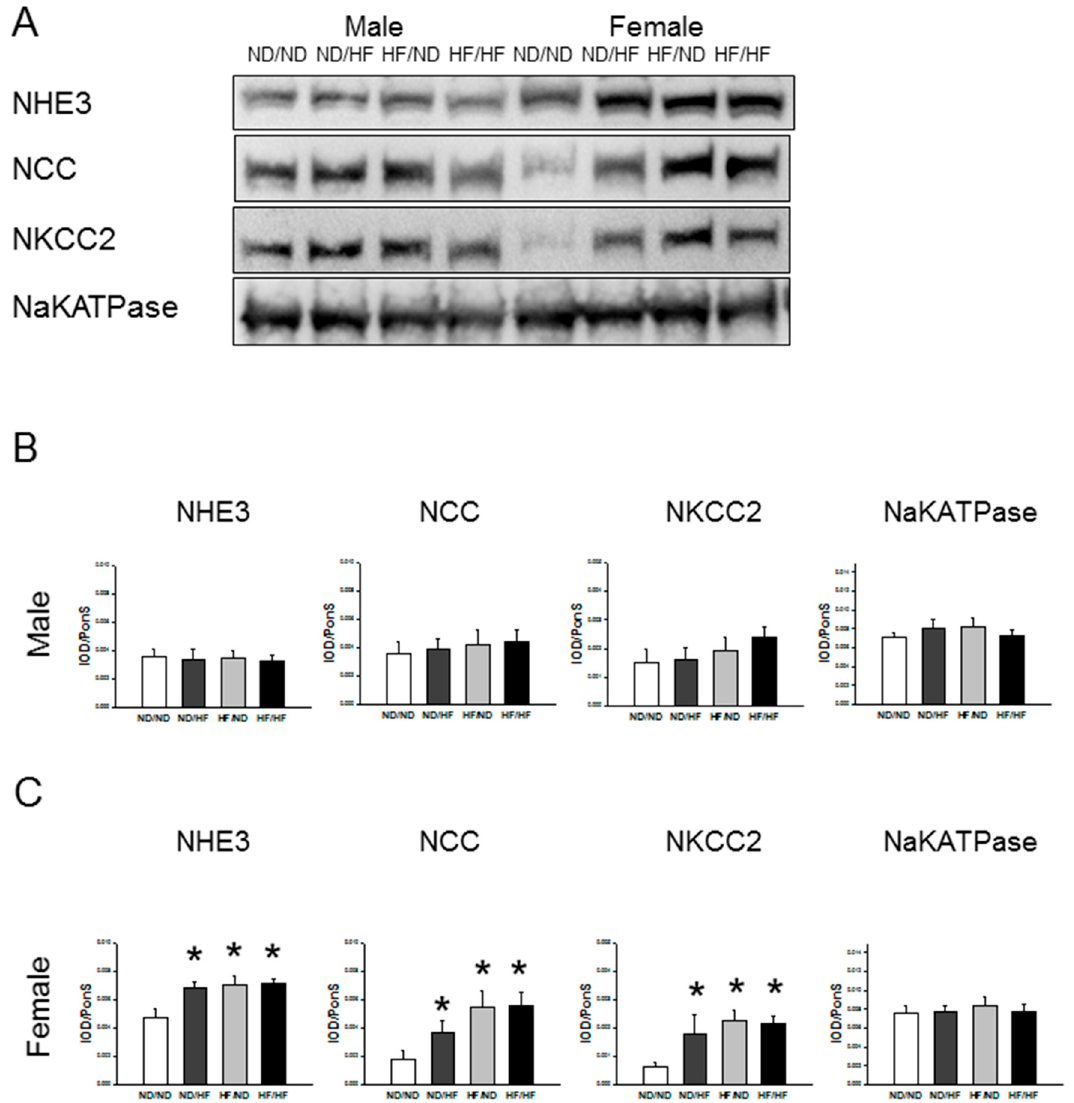
Figure 6. Effects of maternal and postnatal high-fat diet (HF) on sodium transporters expression in male and female offspring. ( A ) Representative Western blots of NHE3 (90 kDa), NCC (130 kDa), NKCC2 (160 kDa), and NaKATPase (112 kDa) of six-month-old male and female offspring. Relative abundance of renal cortical NHE3, NCC, NKCC2, NaKATPase as quantified in: male ( B ); and female ( C ) offspring. * p < 0.05 vs. ND/ND.